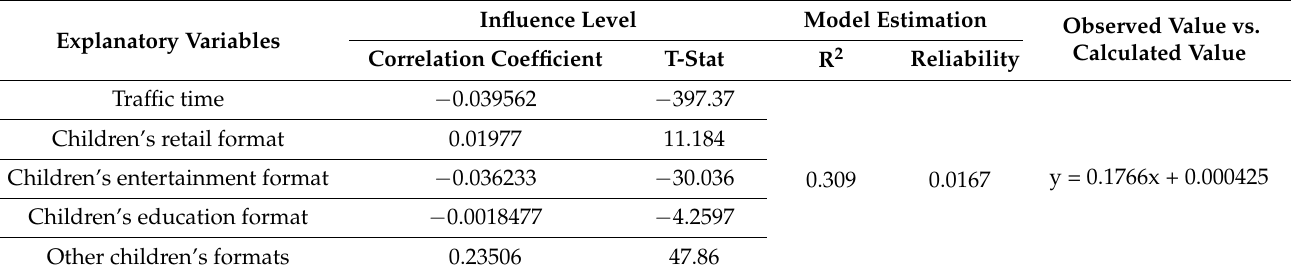
Table 5. Modeling results for commercial centers of